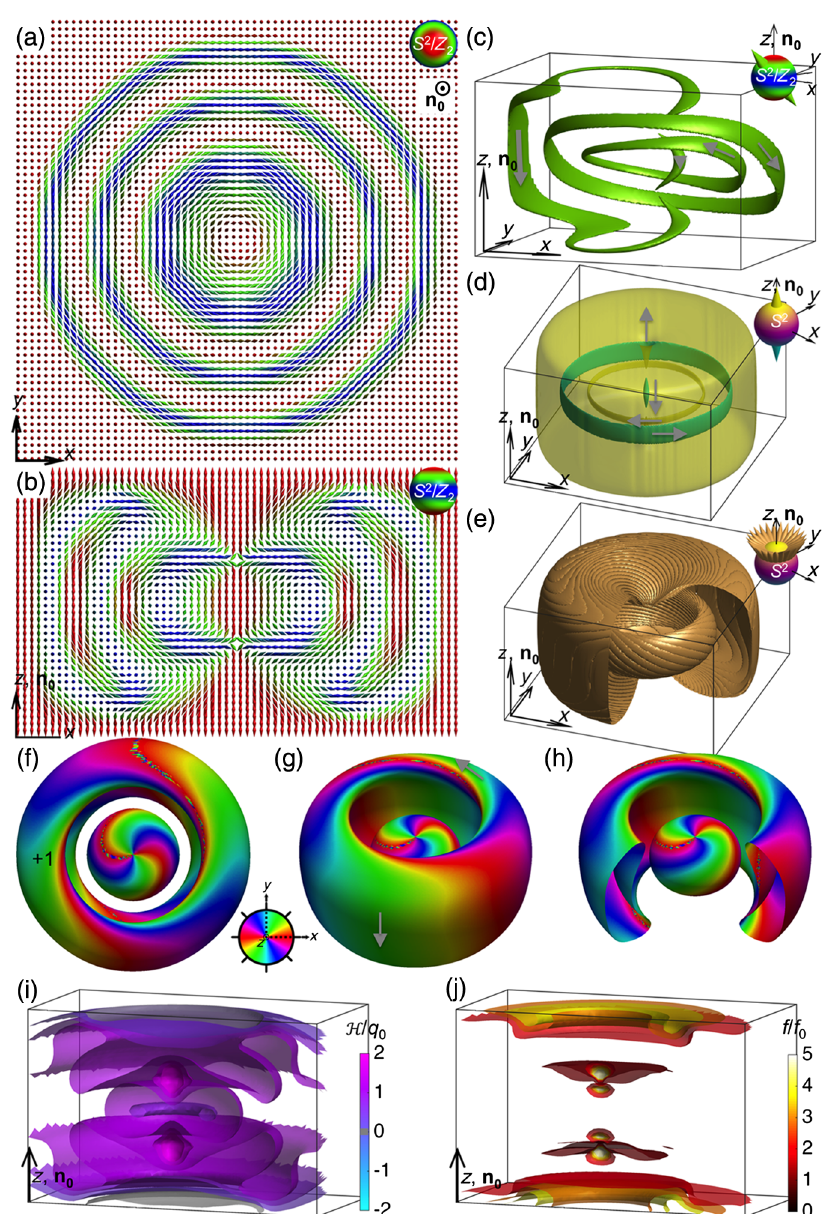
FIG. 11. Toron with complex linking and 3 π twist from its central axis to the far-field periphery. (a), (b) Computer-simulated (a) in-plane and (b) vertical cross sections of the axially symmetric n ð r Þ structure of the toron depicted using double cones and the color scheme that establishescorrespondencebetweendirectororientationsandthepoints on S 2 =Z 2 (topright insets).The twosmallregionsofdiscontinuityin orientation of the double cones are the hyperbolic point defects. (c) A representative computer-simulated preimage of the hopfion for the diametricallyopposite pointson S 2 =Z 2 markedbydouble cones inthe top right inset.Thepreimage iscomposedoftwoclosedloops andtwo half-loop bands terminating on the point defects. (d),(e) Computer-simulated preimages of the toron in a vectorized n ð r Þ (d) for two diametrically opposite points on S 2 corresponding to its north and south poles (top right inset) and (e) for a set of points characterized by a constantpolarangle θ andformingacircleparalleltothesphere ’ sequator(toprightinset).Notethattheclosed-looppreimagesin(e)resideon a torus surface while half-loop bands form another surface spanning between the point defects. A large variety of preimages of this solitonic configuration are shown in Video 3. (f) – (h) Three representative views on the isosurfaces of θ ¼ π = 2 ( n z ¼ 0 ) colored by azimuthal orientations of n ð r Þ according to the scheme shown in the right-hand side inset of (f). The “ þ 1 ” on top of the torus shown in (f) indicates the linkingnumberthatcharacterizesthe interlinkingofcoloredclosed-loopbands andpreimagesof n ð r Þ correspondingtopointsontheequator of S 2 =Z 2 . Gray arrows in (c) and (d) and on the green bands of (g) indicate the consistently determined circulations of the preimages. (i),(j) Perspective views of the 3D computer-simulated isosurfaces of normalized (i) handedness and (j) free-energy density for this axially symmetric toron, with the corresponding color schemes shown in the right-hand side insets. Computer simulations are performed for elastic constants of ZLI-2806 and d=p ¼ 2